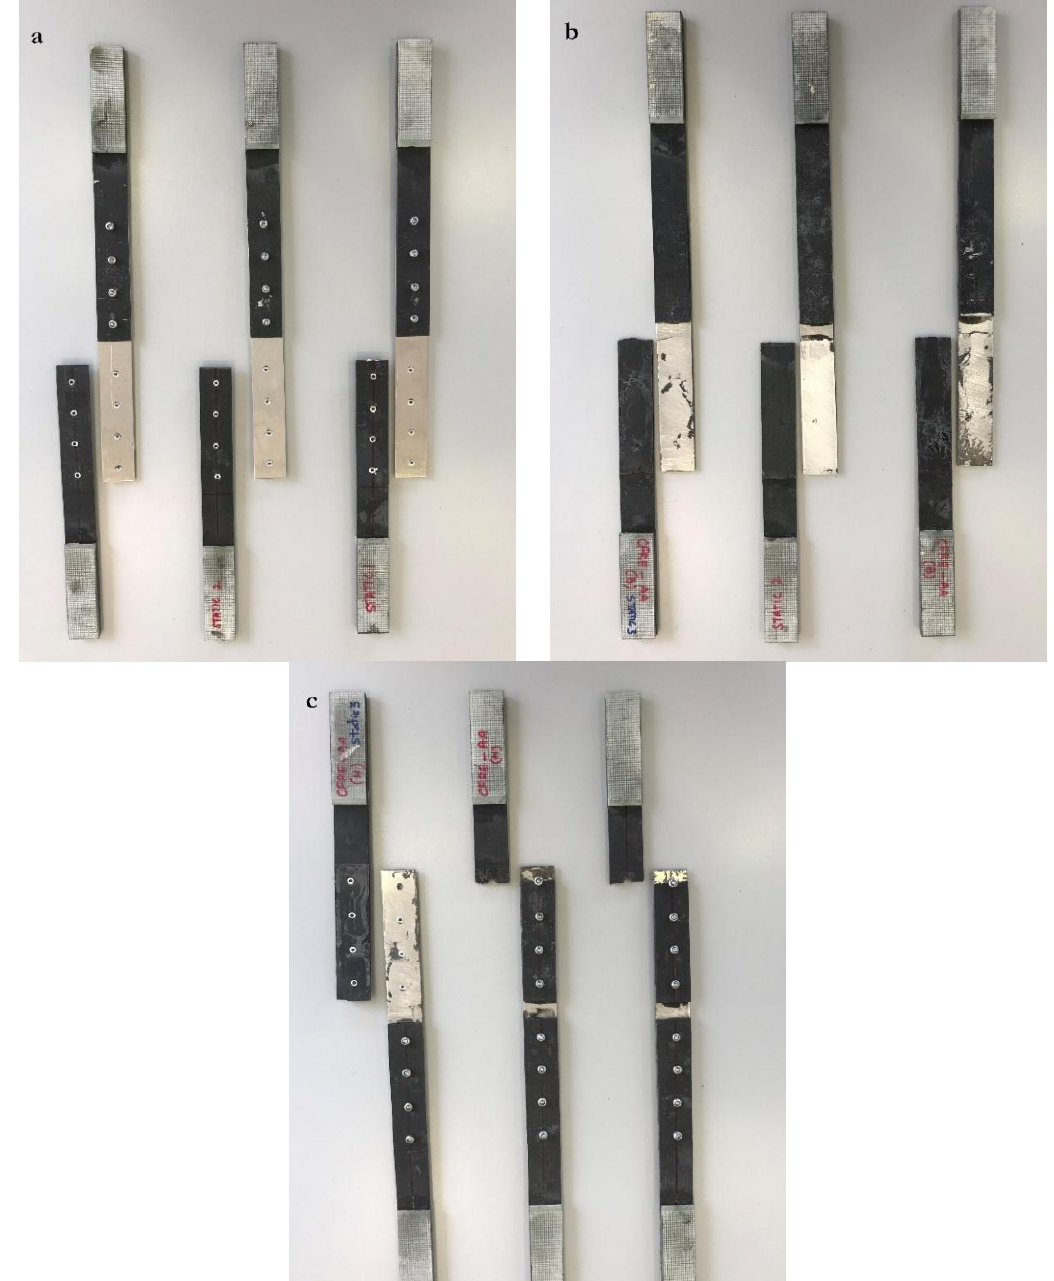
Figure 6. Failure of composite-metal ( a ) riveted, ( b ) adhesive bonded, and ( c ) hybrid